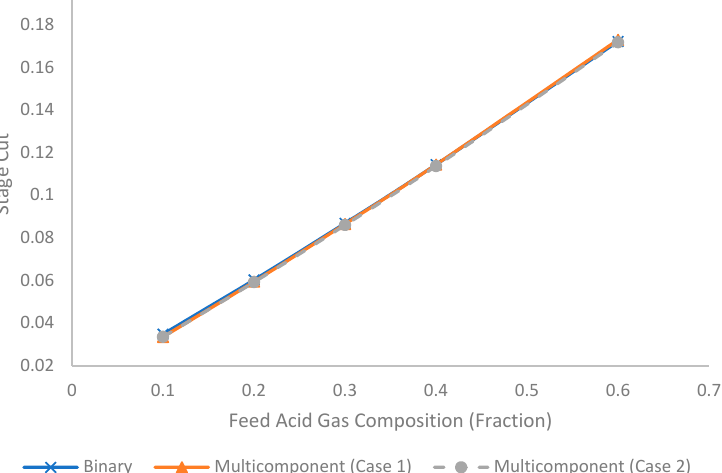
Figure 13. Evolution of stage cut under different acid gas composition (fraction) for binary and multicomponent systems.